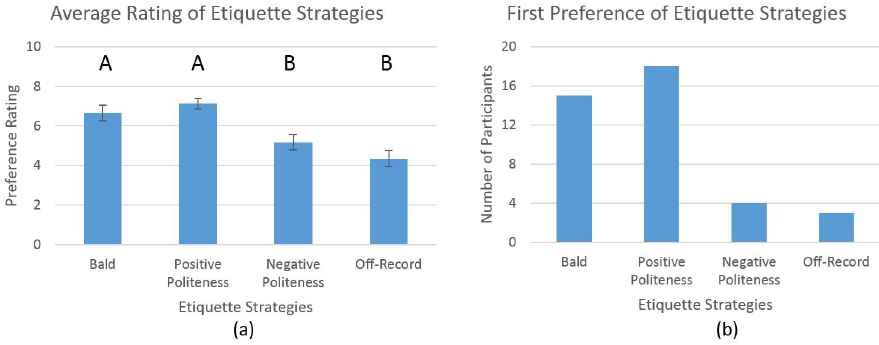
Figure 2. ( a ) Average and standard error of strategies preference ( n = 40); ( b ) Count of preferred